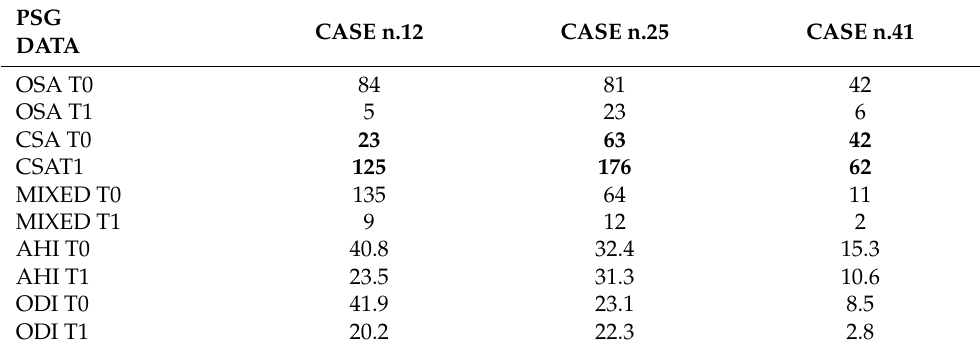
Table 1. PSG parameters of outliers before and after treatment. CSA parameters at T0 and T1 are written in